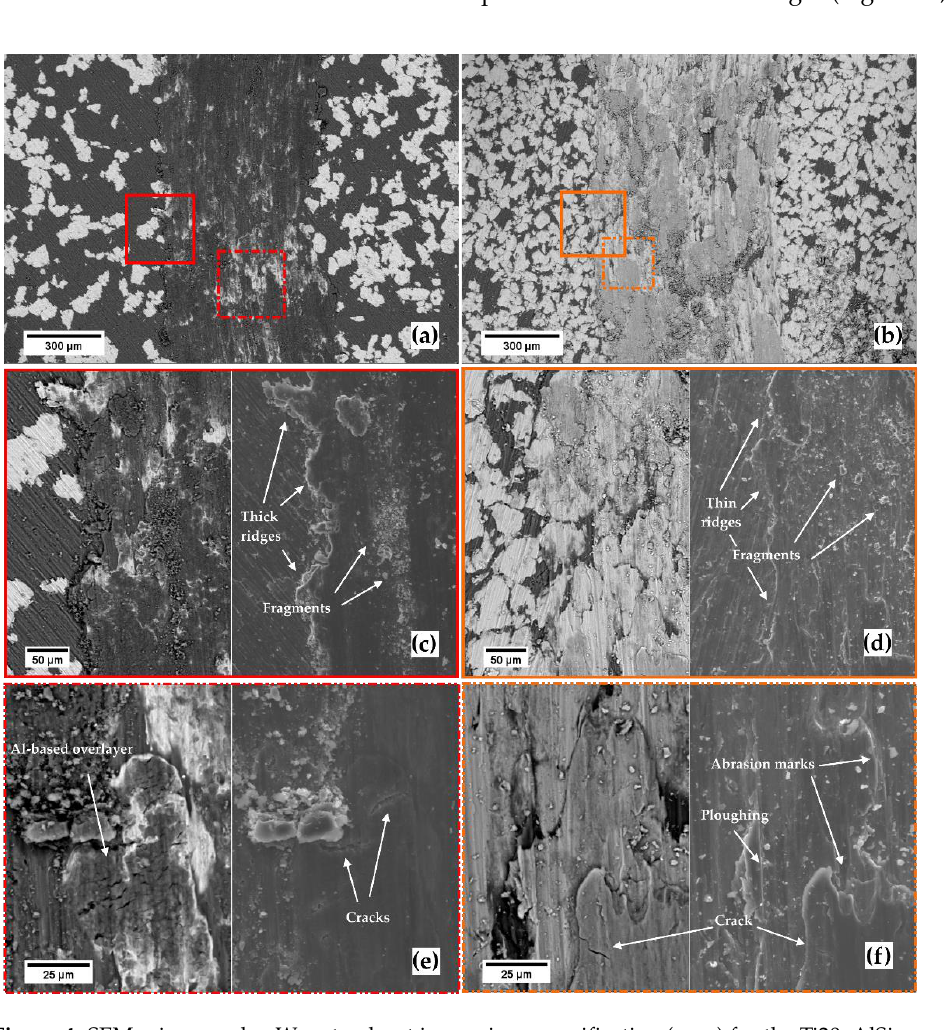
Figure 4. SEM micrographs. Wear tracks at increasing magnification ( a , c , e ) for the Ti20 – AlSi sample, and ( b , d , f ) for the Ti80 – AlSi sample. ( c , d ) refer to the wear track edge, ( e , f ) refer to the middle of the wear track. ( a , b ) and the left micrographs of ( c – f ) are from the backscattered electrons detector; the secondary electron detector acquired the remaining micrographs.